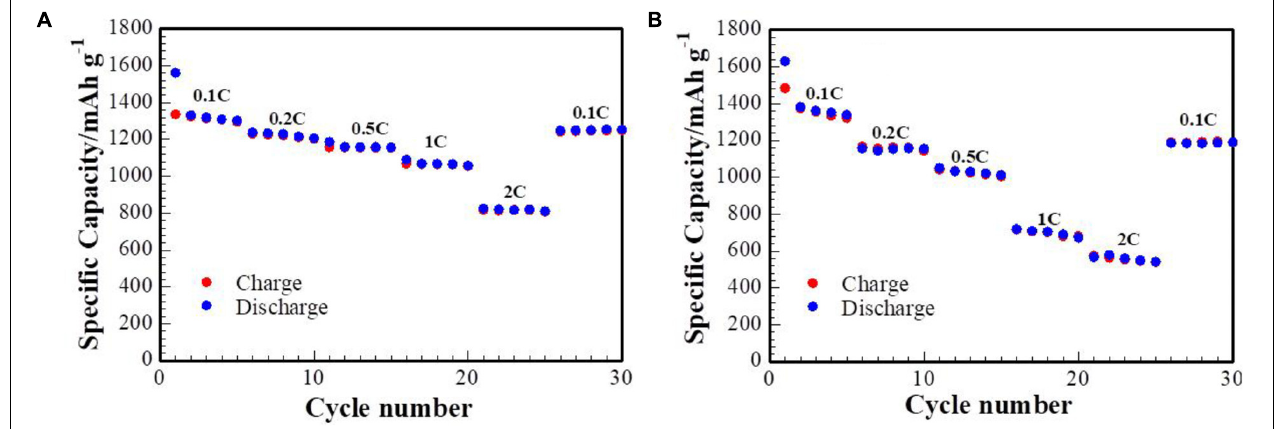
FIGURE 6 | Rate capability test of cells with S/DPAN/CNT composite cathodes. (A) cathode on Al foil current collector (mass loading 1.0 mg cm − 2 ). (B) Cathode on CFP current collector (mass loading 4.0 mg cm − 2 ).